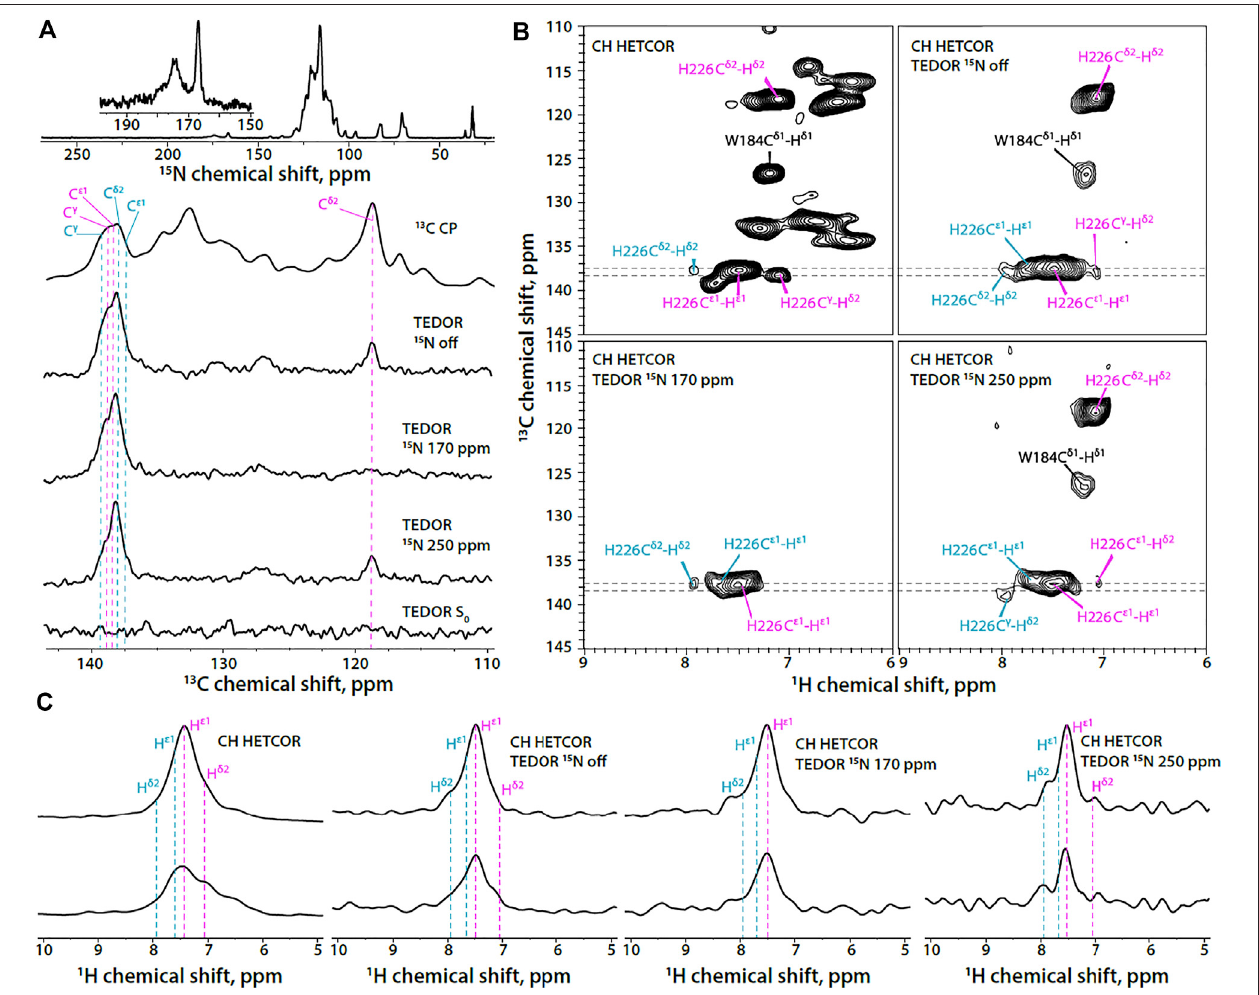
FIGURE 3 | (A) 1D 15 N CPMAS and 13 C MAS NMR spectra of U- 13 C, 15 N-CA CTD -SP1 with TEDOR-based 15 N selective fi ltering in the aromatic region (MAS frequency 14 kHz).Toptobottom: 15 NCPMASspectrum; 13 CCPMASspectrum;TEDOR-based 15 Nselectively fi lteredspectrawithsoftpulseturnedoff,softpulseat170 ppm,soft pulse at 250 ppm, and a reference ( S 0 ) experiment. (B) Aromatic regions of 1 H-detected TEDOR-based 15 N selective fi ltered CH HETCOR spectra in U- 13 C, 15 N-CA CTD - SP1:TEDOR fi lterandsoftpulseturnedoff (topleft) ,softpulseturnedoff (topright) ,softpulseat170 ppm (bottomleft) ,softpulseat250 ppm (bottomright) .The fi rst contour was set at 5 × the noise rmsd. (C) 1D 1 H slices of 1 H-detected TEDOR-based 15 N selective fi ltered CH HETCOR spectra in U- 13 C, 15 N-CA CTD -SP1, extracted at 13 C shifts shown as gray dashed lines in panel (B) . Left to right: TEDOR fi lter and soft pulse turned off, soft pulse turned off, soft pulse at 170 ppm, soft pulse at 250 ppm. The MAS frequency was 60 kHz. Signals of τ tautomer and π tautomer are shown in magenta and teal, respectively.